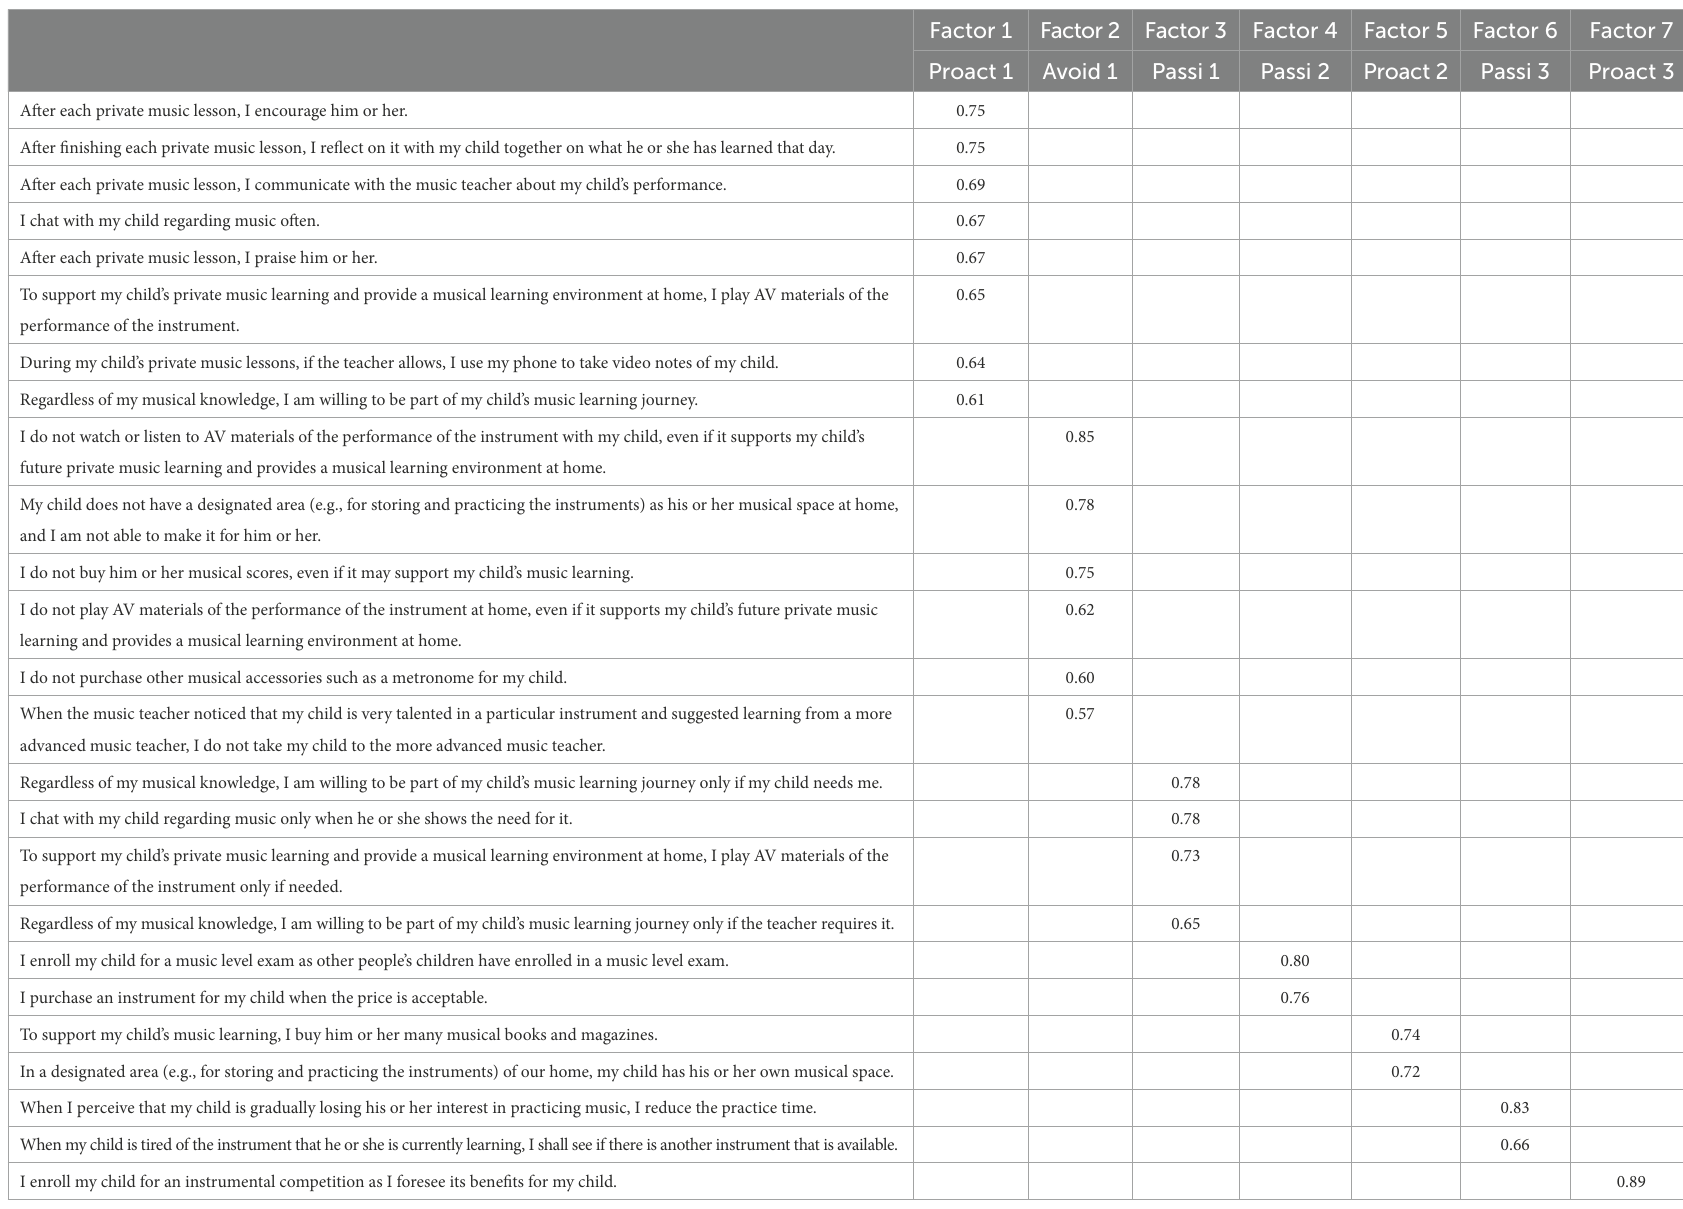
TABLE 2 Exploratory factor analysis of PLAPMLS with varimax rotation ( n = 320).